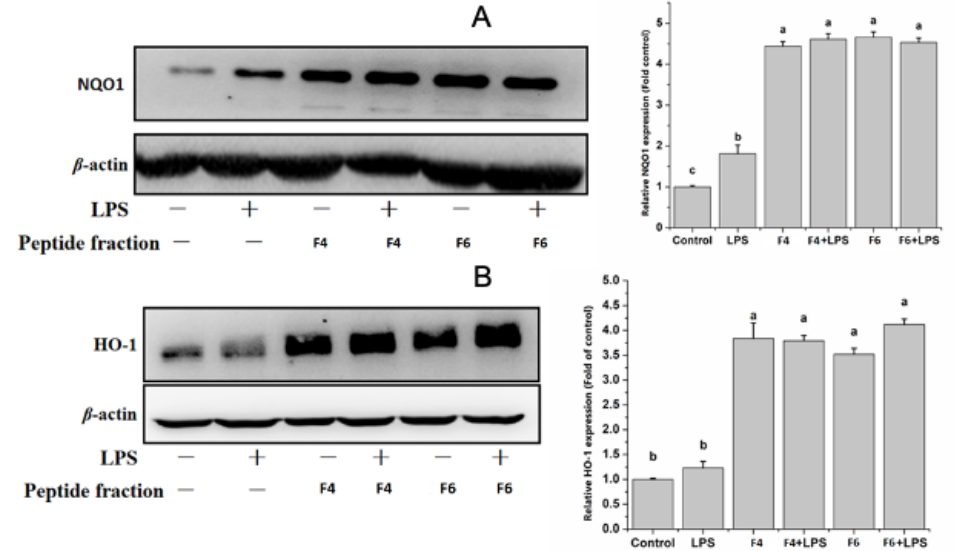
Figure 6. ( A , B ) Effects of F4 and F6 on LPS-induced antioxidant responses in endothelial cells. Eighteen hours after LPS addition, HO-1 and NQO-1 expression was measured by immunoblotting. The contents in the control groups were set as 1, and the values in the other groups were relative values to the control group. Protein bands were quantified by densitometry and normalized to their respective loading controls. The values are expressed as mean ± SD. Data are the results of the averages of at least three different experiments. Statistical difference ( p < 0.05) is denoted by letters a–c. Shared letters indicate no significant